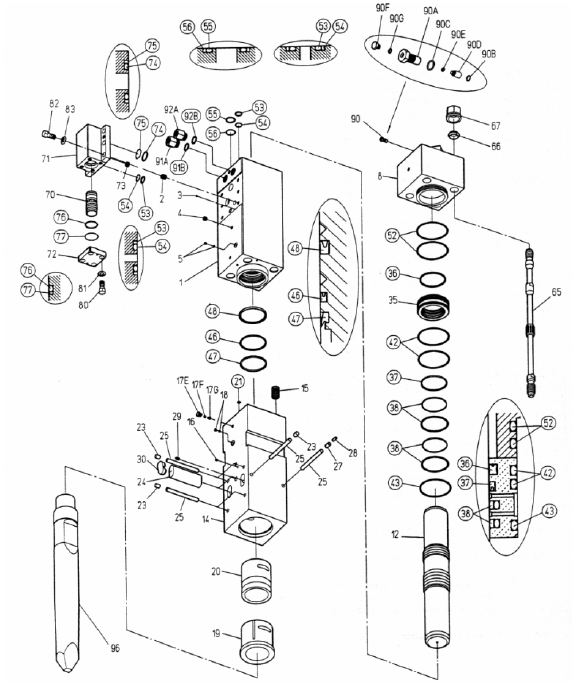
Figure 6 – Explosion scheme of the hydraulic hammer